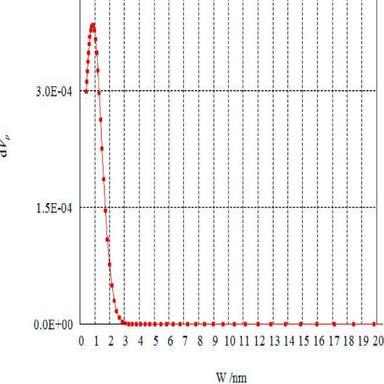
BET-plot (a), adsorption desorption isotherms (b) and pore size distribution (c) of SiO2@C nanocomposite (SC1).